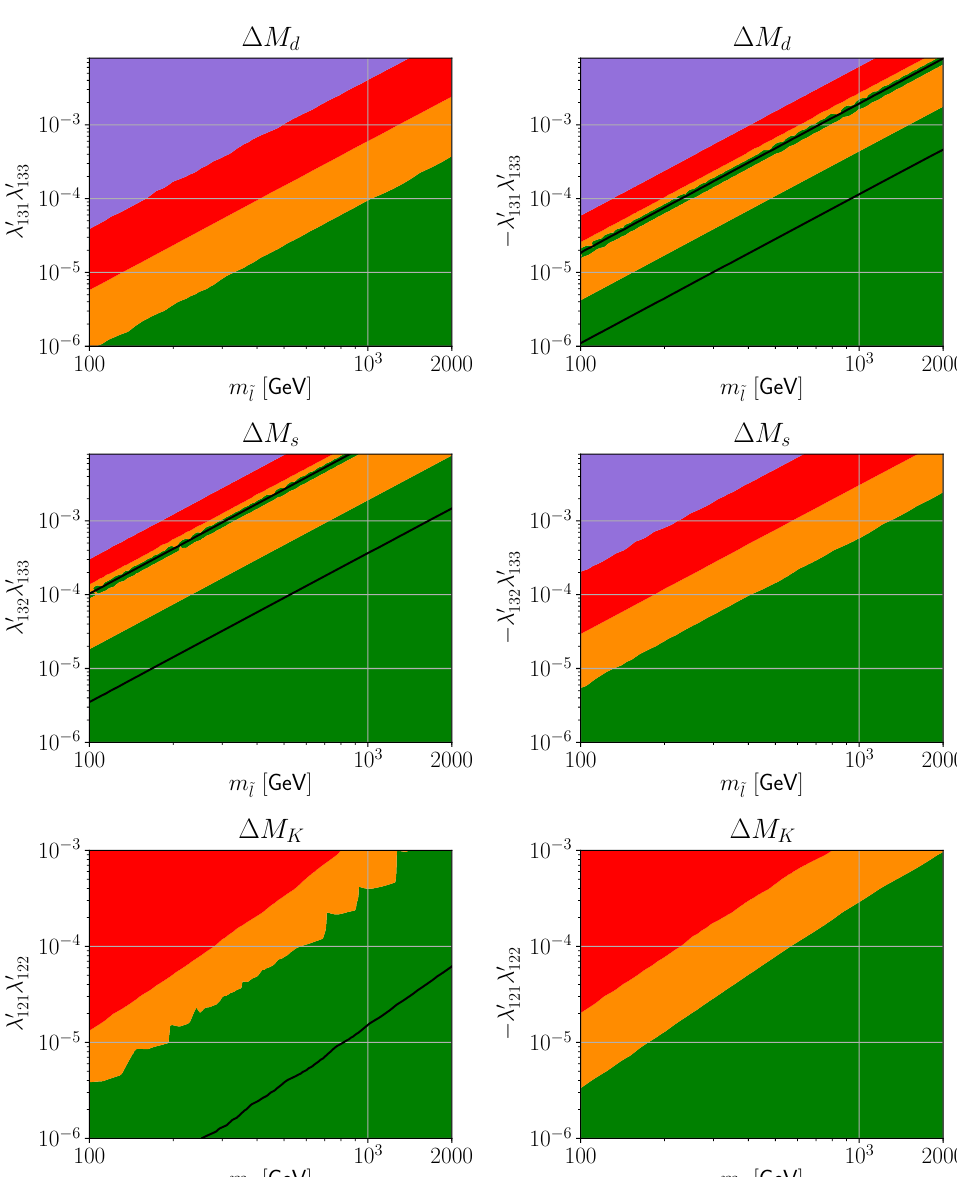
Figure 5. Constraints from the (cid:1) M ’s on scenarios with RpV-mediated (cid:13)avor violation of LQ (cid:22) D - type, where the dominant RpV-diagram involves a one-loop quark self-energy. The limits are plotted against the sneutrino mass and follow the color code of (cid:12)gure 3. For these plots, the parameter set of the scenario SUSY-RpV(a) of table 1 has been employed.